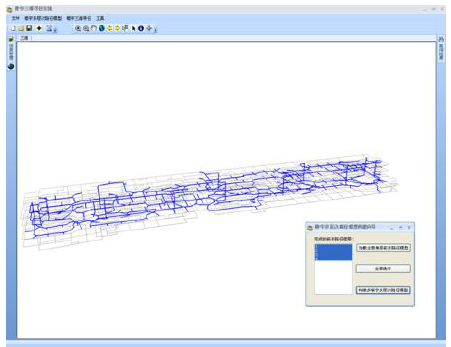
Figure 10 The result of route modelling for multi-floor in Longjiang New City Plaza